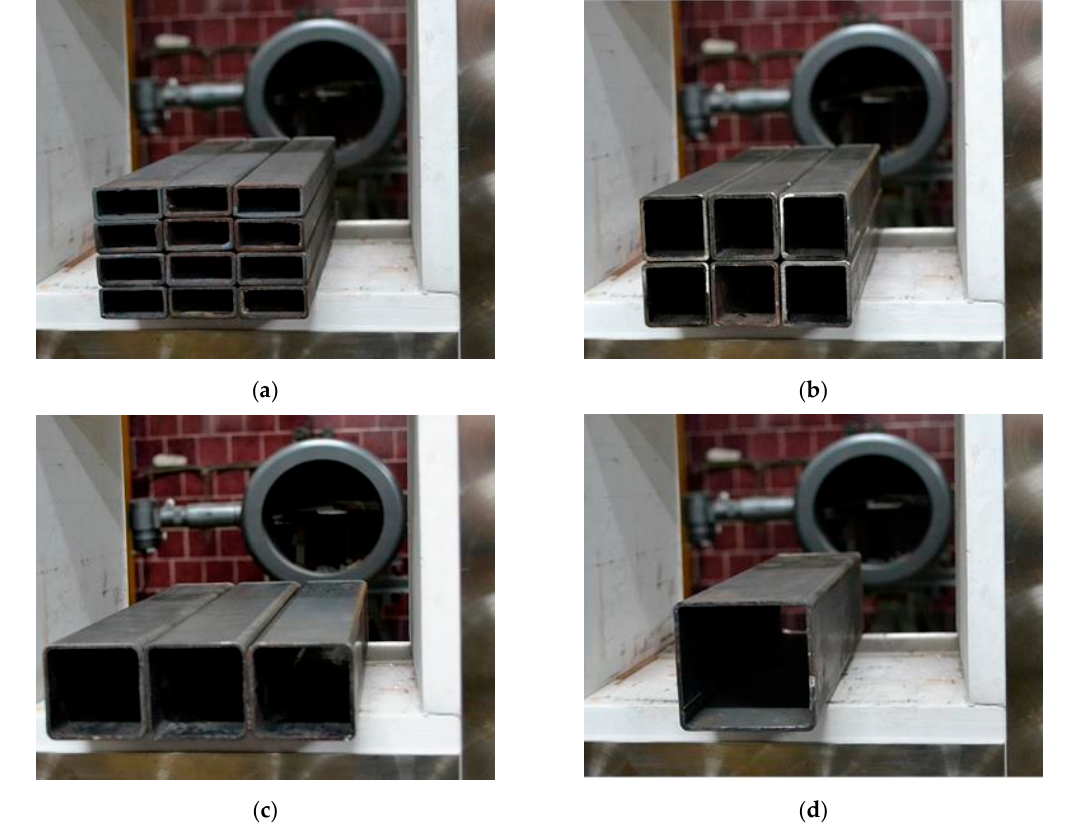
Figure 11. The samples examined by means of Schlieren imaging: ( a ) a bed of 20 × 40 mm sections; ( b ) a bed of 40 × 40 mm sections; ( c ) a layer of 60 × 60 mm sections; ( d ) a single 80 × 80 mm section.